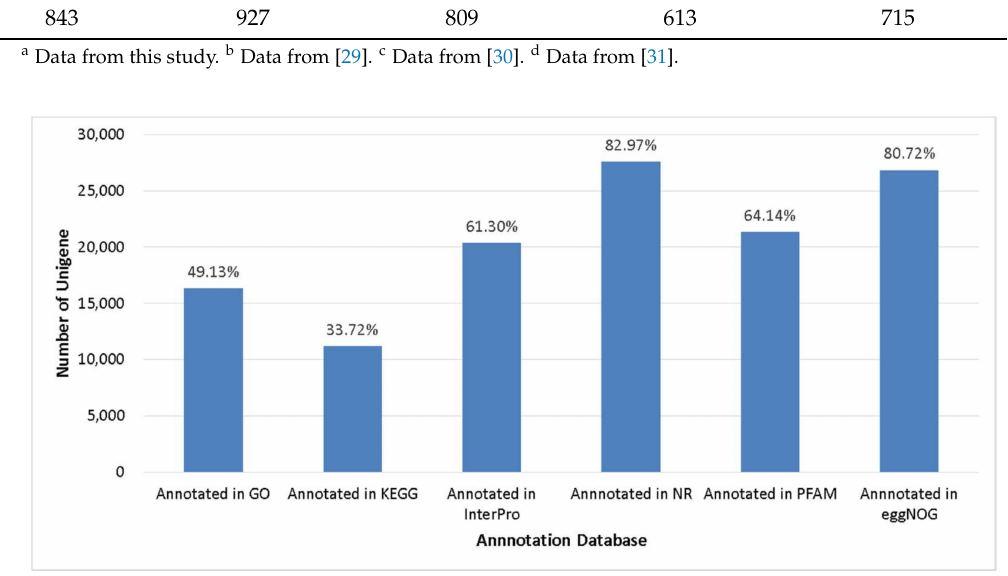
Figure 2. Unigenes annotated in several